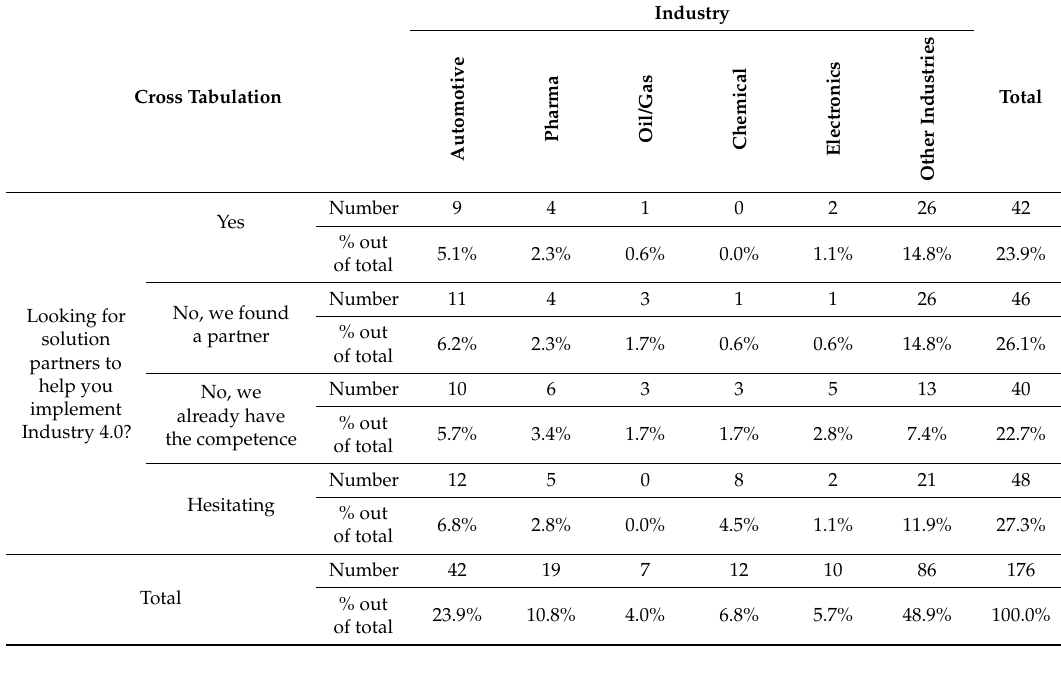
Table 2. Contingency table on searching for solution sartners for implementing technologies according to industry types.